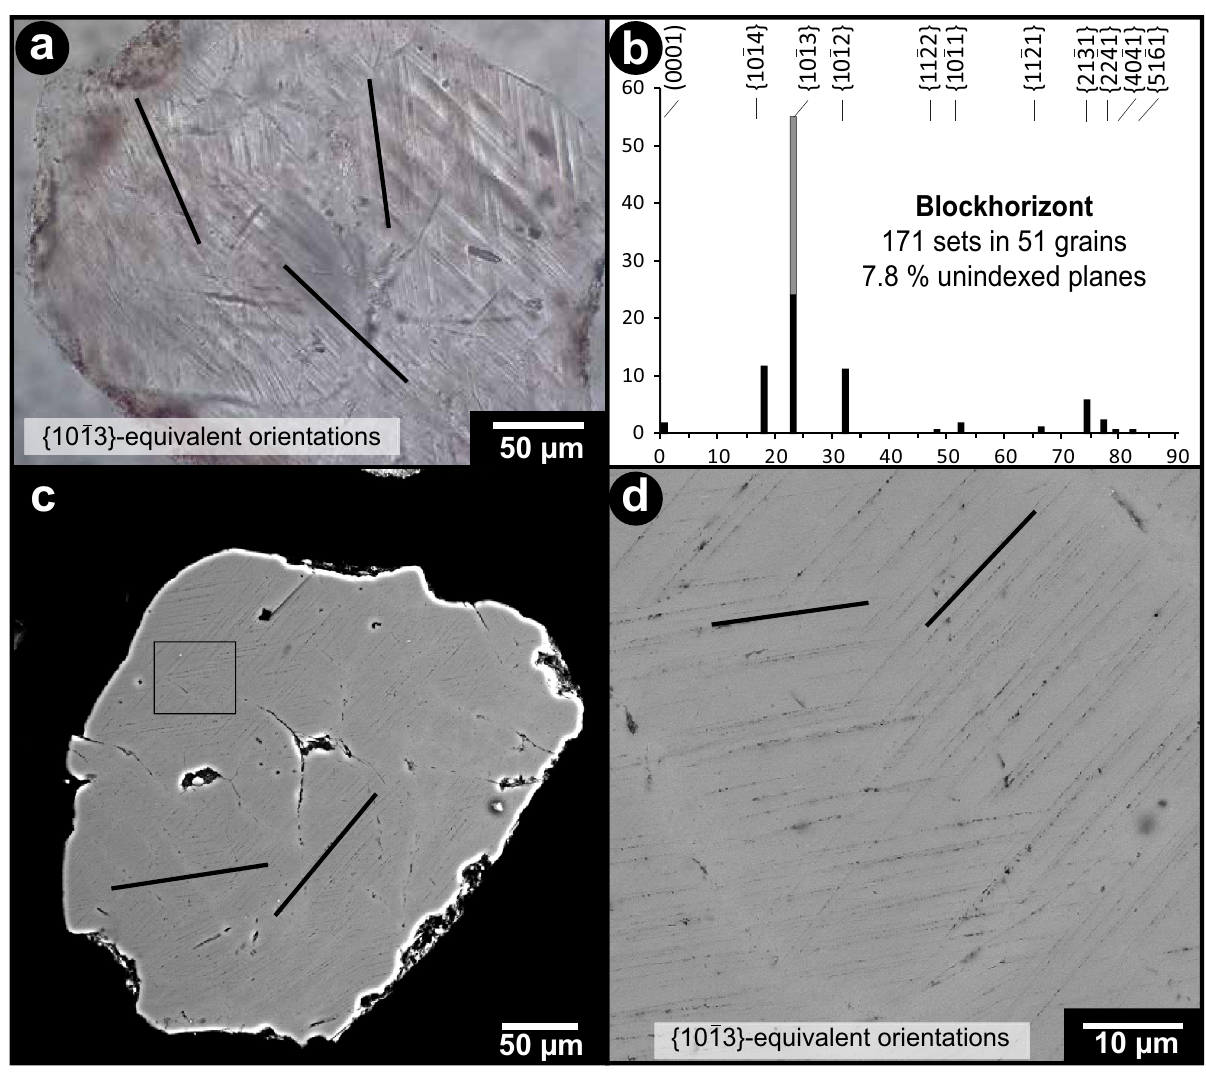
Figure 5. ( a ) Microphotograph of a quartz grain from the Blockhorizont displaying three PDF sets. ( b ) Histogram of the absolute frequency percent of indexed PDFs in quartz from the Blockhorizont. PDFs that plot in the overlapping zone between the { 1014 } and { 1013 } orientations are plotted in grey on top of the uniquely indexed { 1013 } planes (as recommended by Ref. 31 ). ( c ) Backscattered electron image of a shocked quartz grain from the Blockhorizont. ( d ) Close-up of PDFs from the grain in ( c ) showing the decorated nature of the